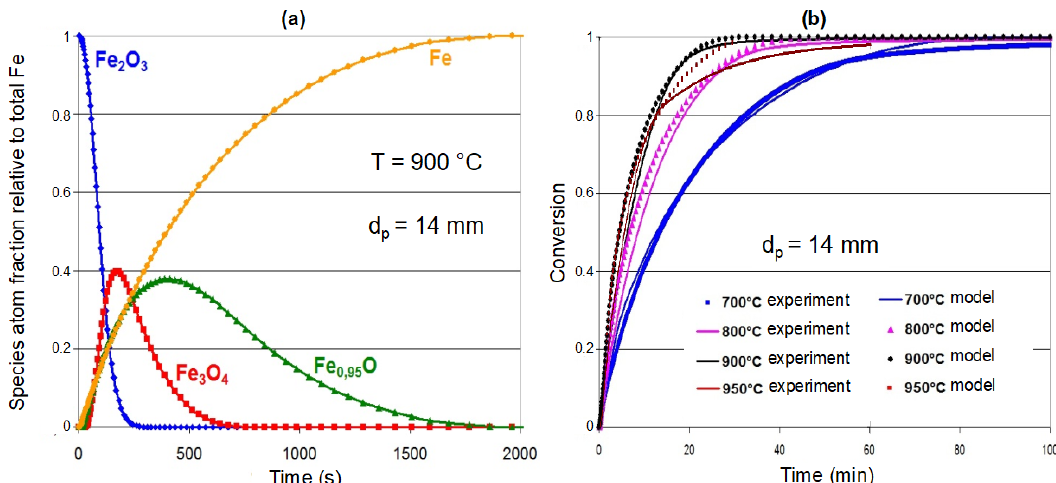
Figure 8. Results of the single pellet model; ( a ): calculated solid fractions as a function of time; ( b ): comparison with experimental data at various temperatures for a CVRD-DR pellet reduced by 2 L/min of H 2 -He (60–40 vol. %) in a thermobalance.